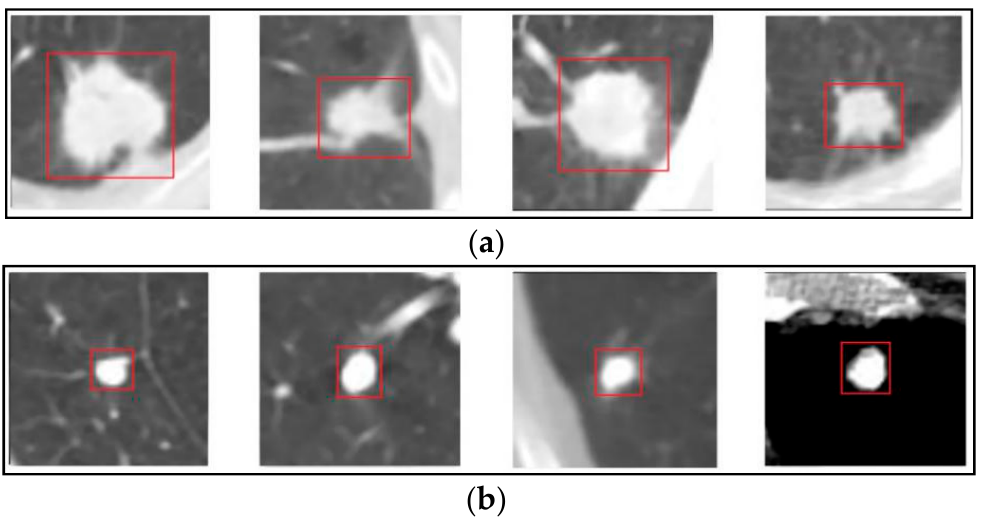
Figure 5. High malignancy suspicious cases are given in ( a ) and low malignancy suspicious cases are given in ( b ) [13]. Red bounding boxes denote the locations of the nodule.